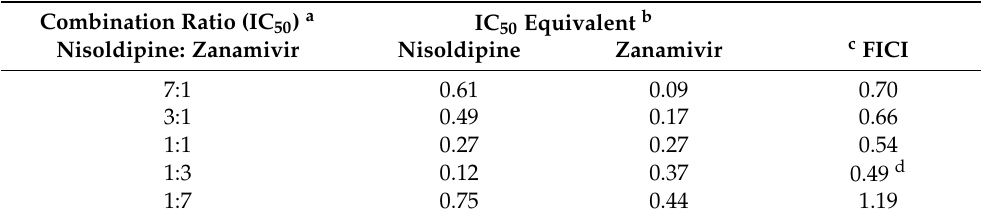
Table 4. In vitro synergistic anti-influenza activity of nisoldipine with